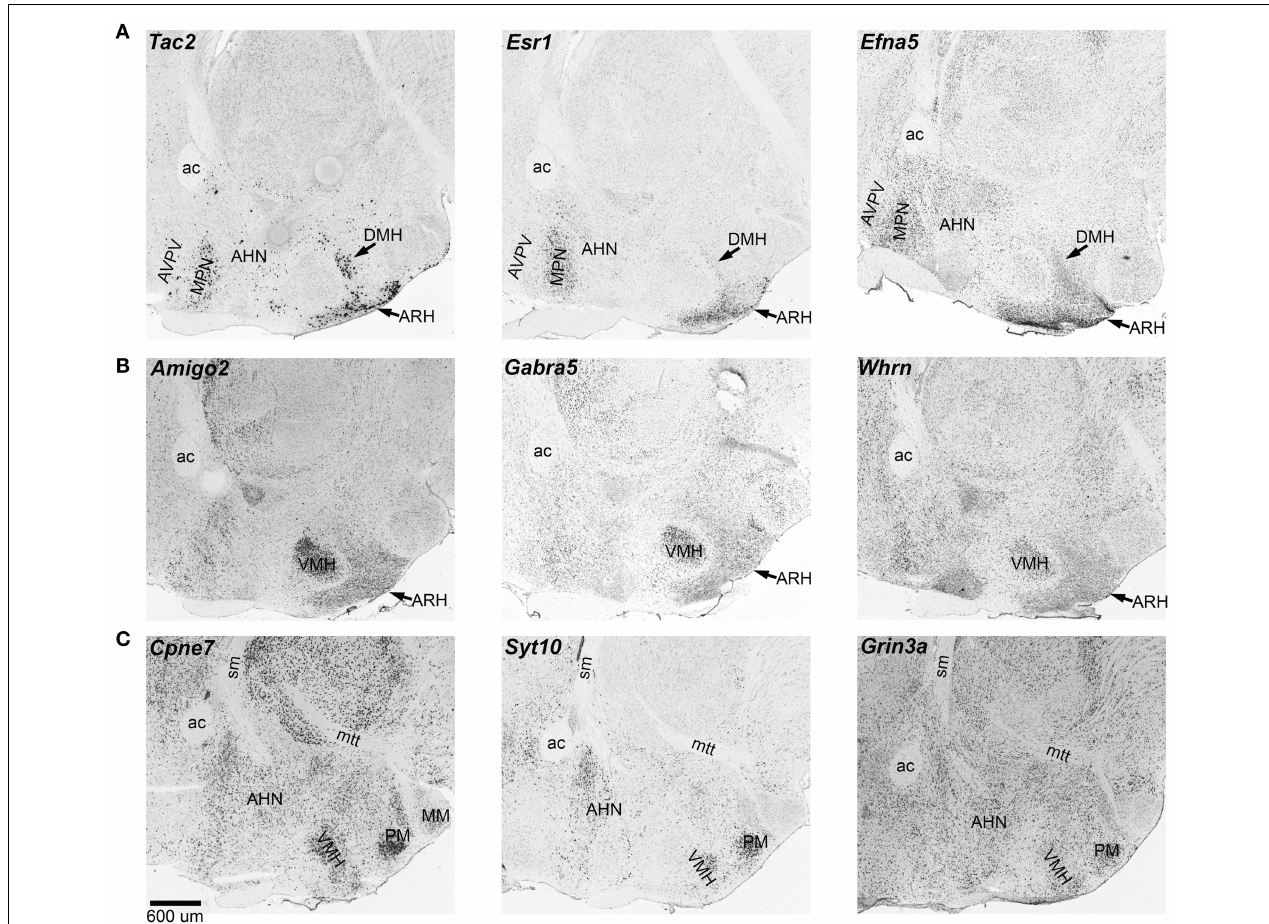
more intense expression in the ventromedial hypothalamus, the anterior hypothalamus, and the mammillary areas. ac, anterior commissure; AHN, anterior hypothalamic nucleus; ARH, arcuate hypothalamic nucleus; AVPV, anteroventral periventricular nucleus; DMH, dorsomedial hypothalamus;